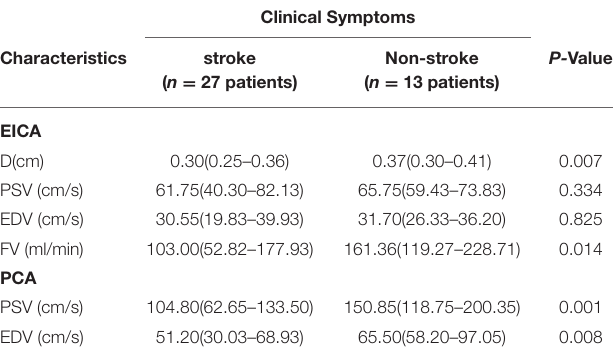
TABLE 2 | Comparison of ultrasound parameters between the stroke group and the non-stroke group in patients with